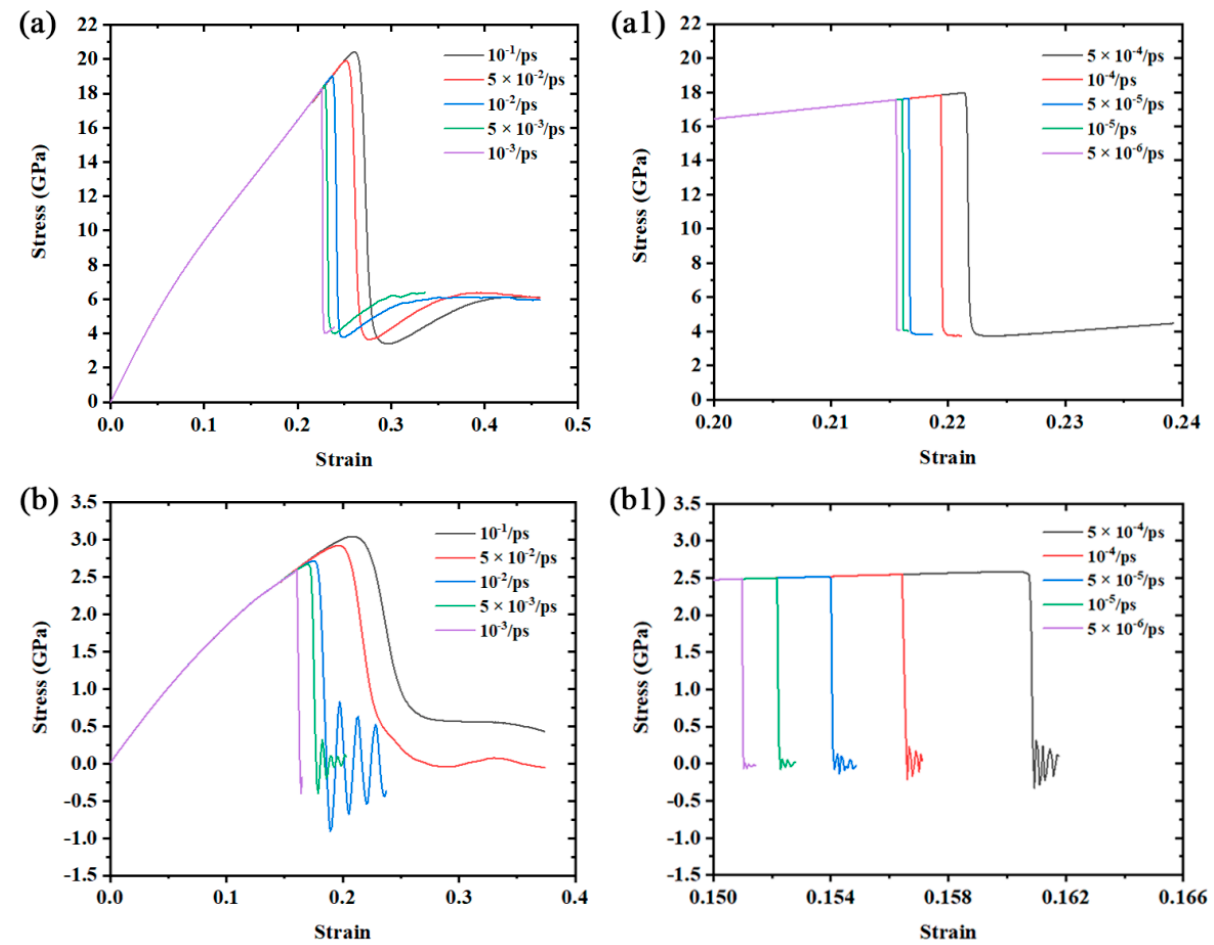
Figure 2. Stress–strain curves of the two structures under the simulated strain rates: ( a ) Mono-Si, strain rate range: 10 − 1 /ps to 10 − 3 /ps; ( a1 ) Mono-Si, strain rate range: 5 × 10 − 4 /ps to 5 × 10 − 6 /ps; ( b ) SiNW, strain rate range: 10 − 1 /ps to 10 − 3 /ps; ( b1 ) SiNW, strain rate range: 5 × 10 − 4 /ps to 5 × 10 − 6 /ps.